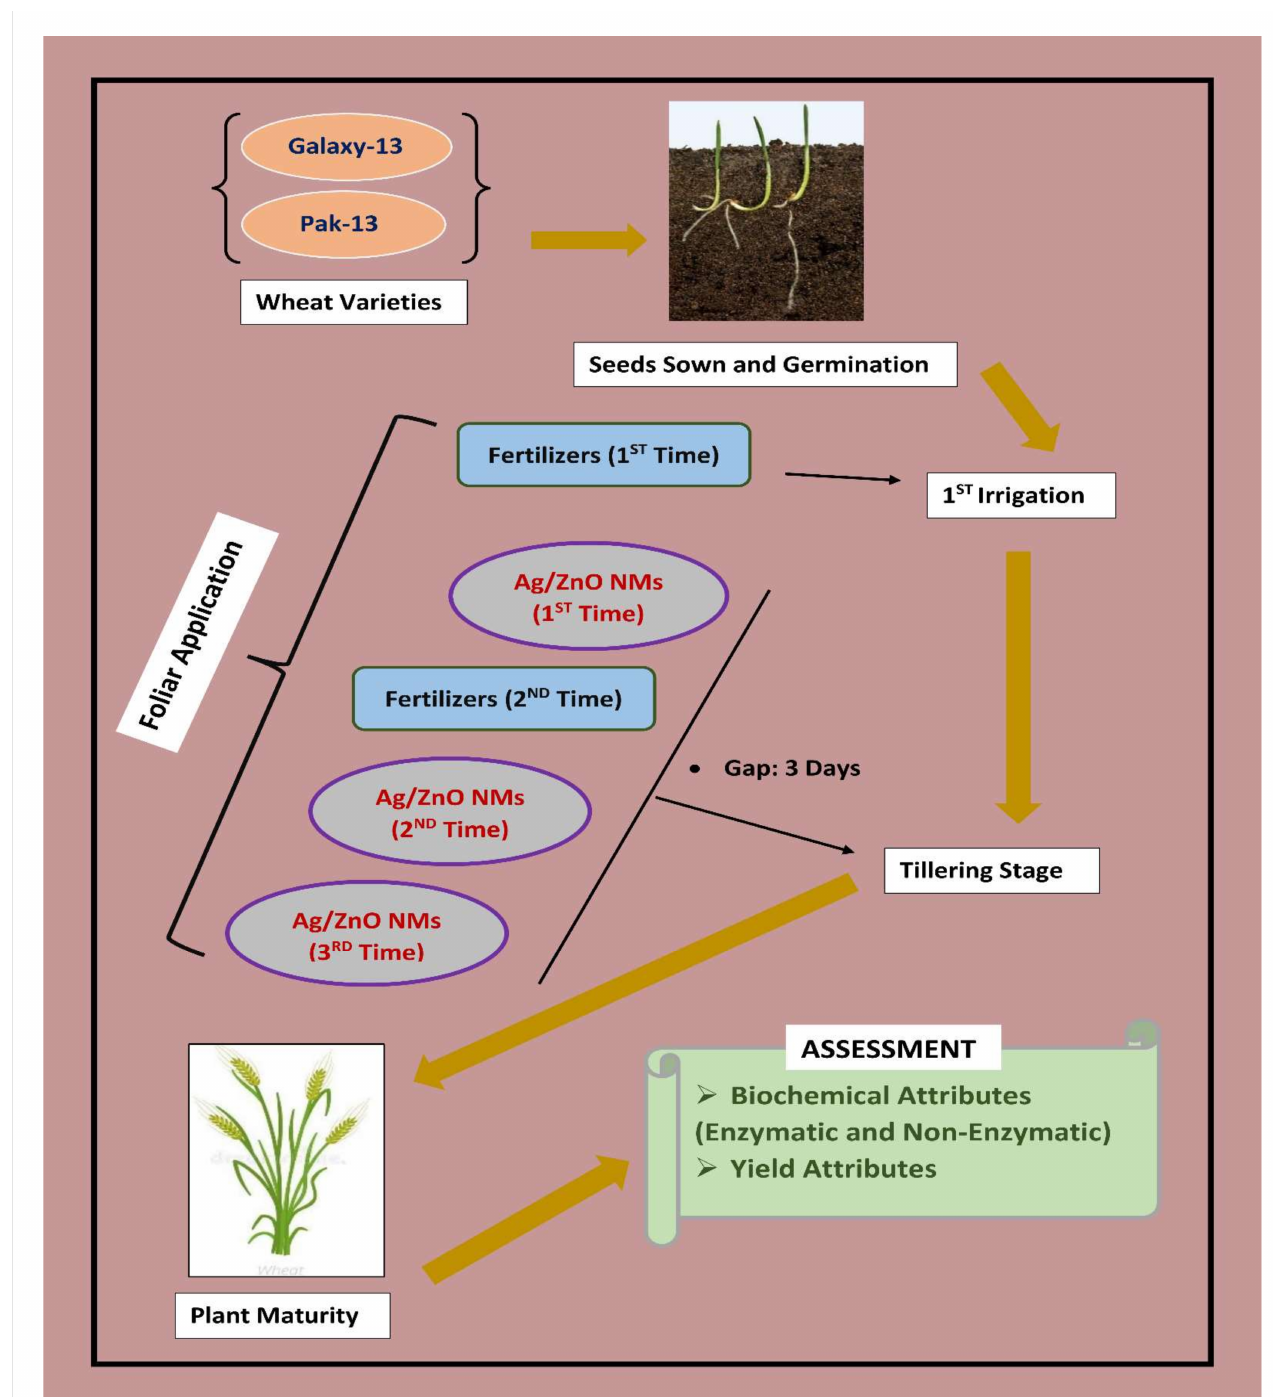
Figure 2. Schematic illustration of research